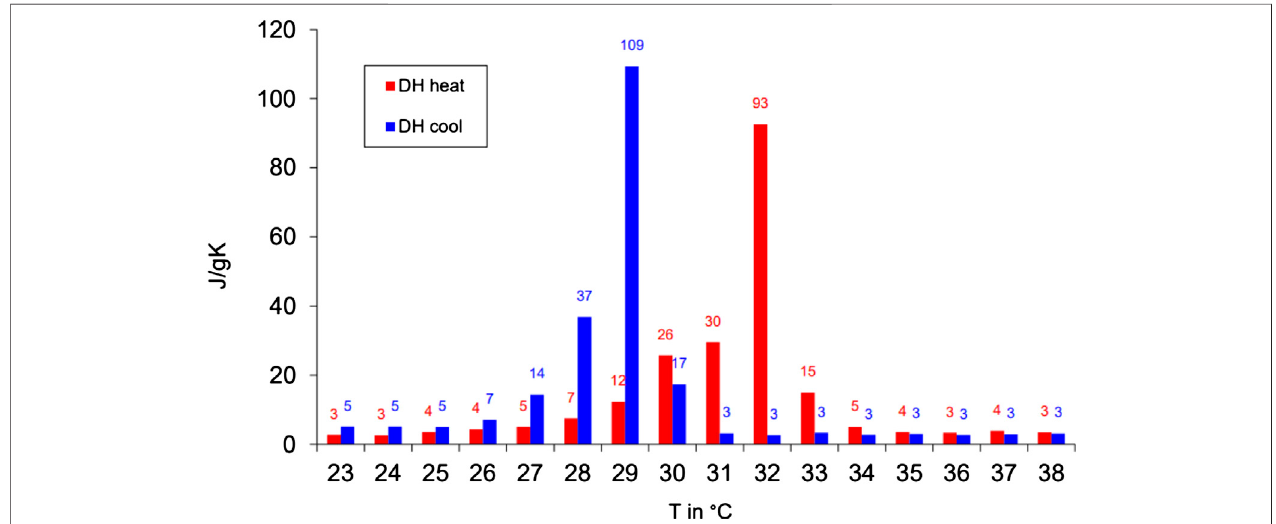
FIGURE 5 | Partial enthalpy distribution of the phase change material ATS30 (Axiotherm, 2020).